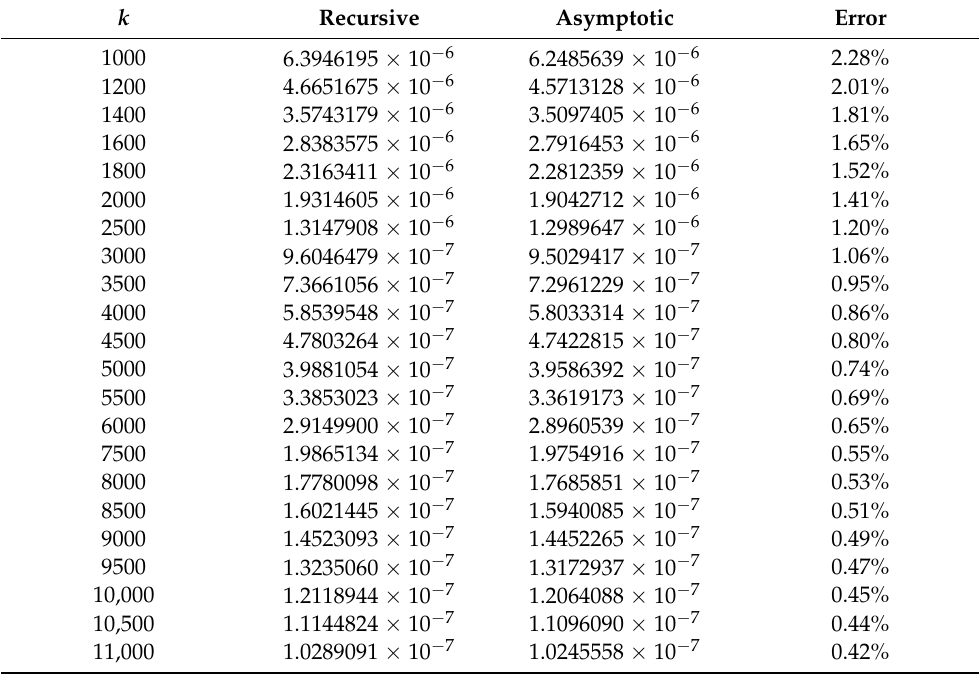
Table 1. Comparison of exact and asymptotic p k . m = 58.7, (cid:101) = 0.005, w = 1.4.